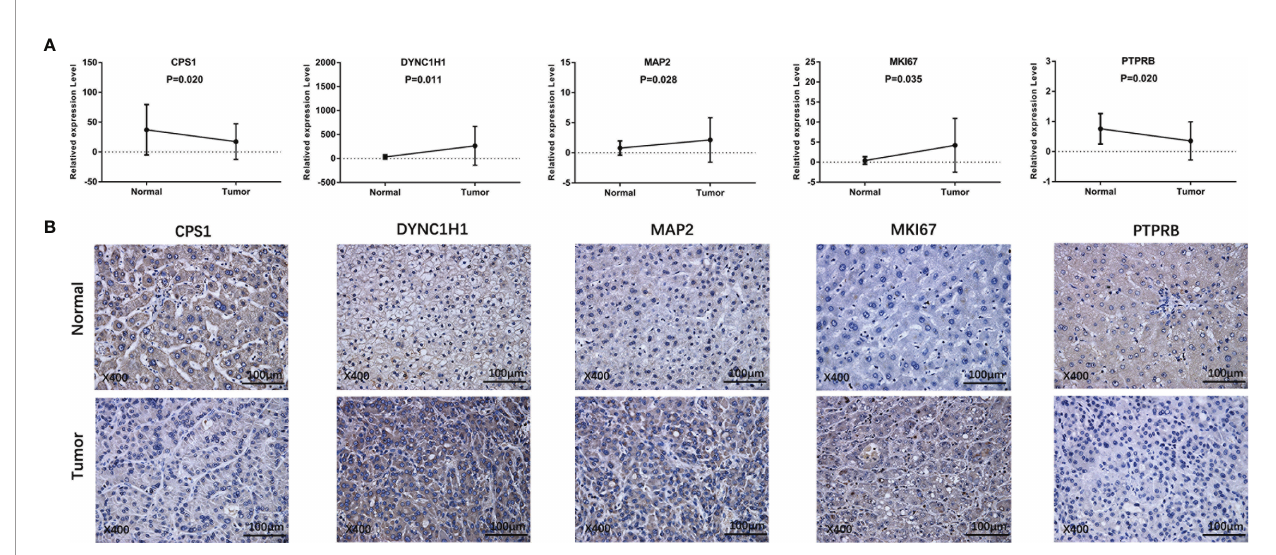
FIGURE 10 | Prognostic gene expression between HCC and paracancerous tissues was validated by independent sample cohorts. (A) qRT-RCR. (B) IHC.